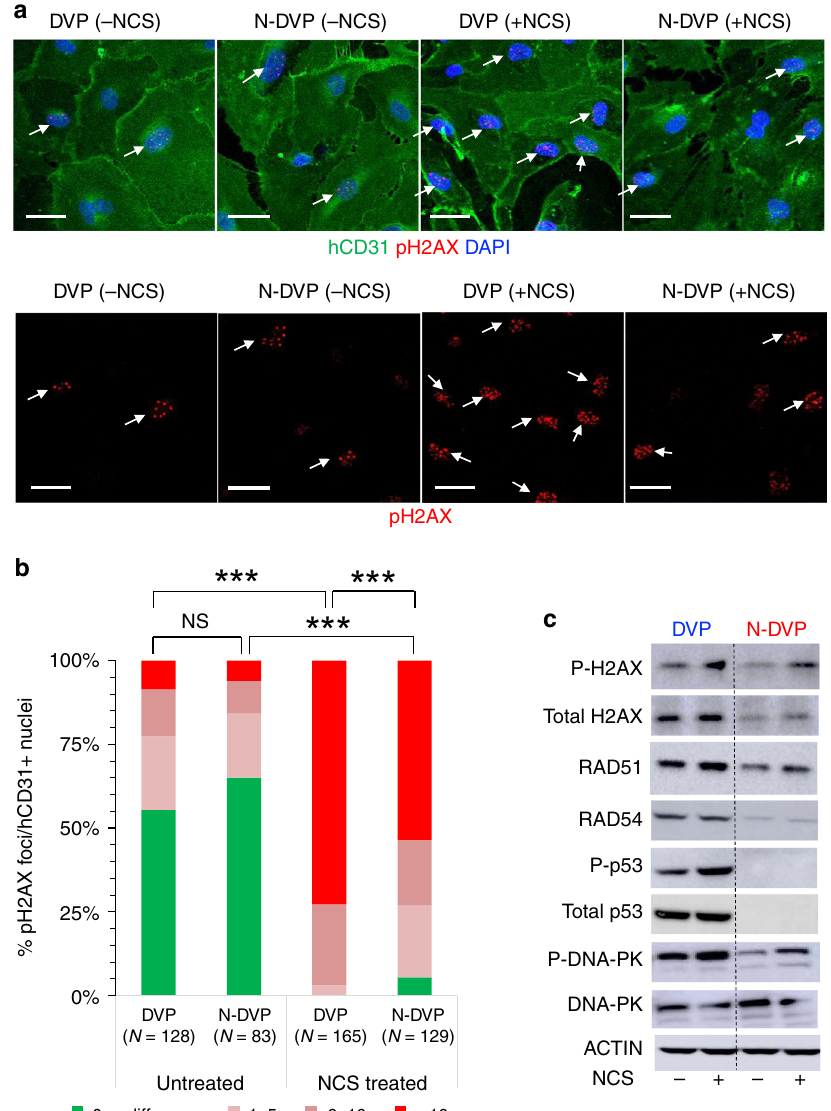
Fig. 5 DNA damage response of primed vs. naïve DVP. a puri fi ed and expanded DVP or N-DVP (E1CA2) were treated with the radiomimetic drug NCS for 5 h before fi xation and staining with antibodies for detection of human CD31 + cells and phosphorylated H2AX (pH2AX) positive nuclear foci (i.e., DAPI co- staining) to reveal double-strand DNA breaks (arrows); Scale Bar = 50 μ m. b Quanti fi cation of pH2AX foci per nuclei in isogenic DVP vs. N-DVP with or without induction of NCS DNA damage. Shown are numbers of DAPI + nuclei per fi eld with no pH2AX foci (green), and DAPI + nuclei with 1 – 5 foci (light pink), 6 – 10 (dark pink) and >10 pH2AX foci (red). *** p < 0.0001; Chi-Square tests ( c ) Lysates of primed DVP and N-DVP (E1C1) cultured in EGM2 and treated with ( + ) or without ( − ) NCS were analyzed by Western blotting for expressions of proteins activated by DNA damage and apoptosis ( i.e., total H2AX and phosphorylated H2AX (P-H2AX), RAD51, RAD54, phosphorylated p53 (P-p53), total DNA-PK, and phosphorylated DNA-PK